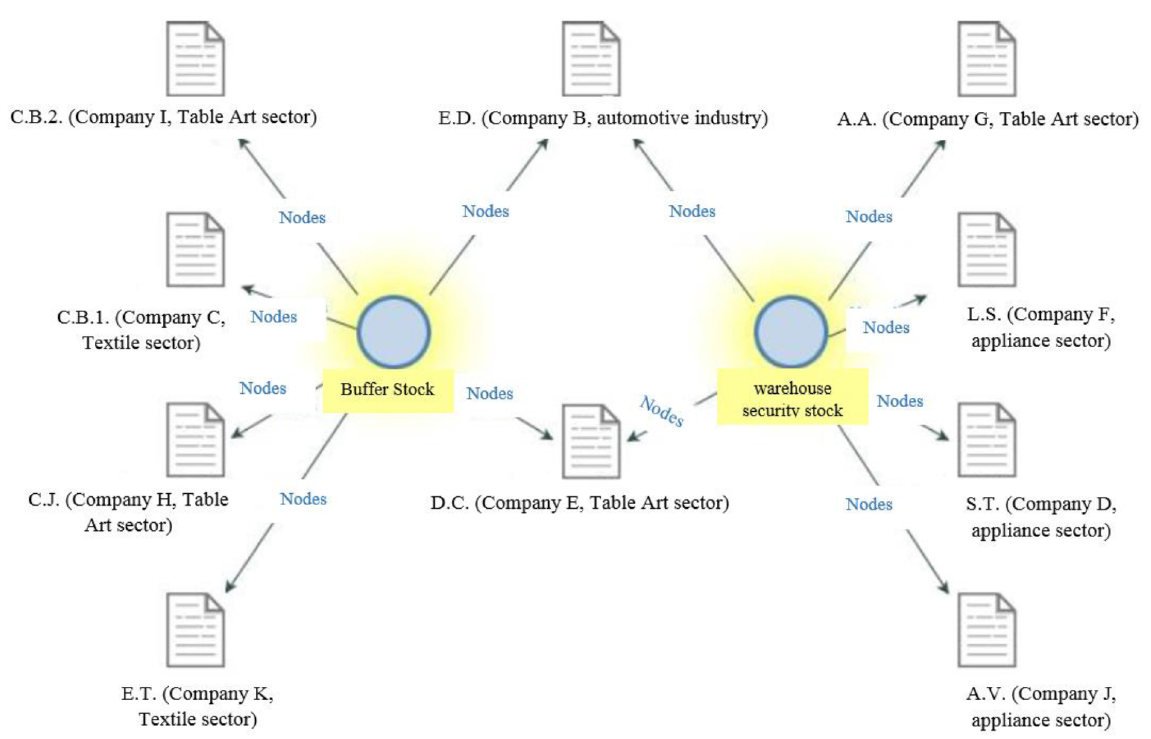
Figure 3. Encoding of the “buffer stock” and “warehouse stock” nodes under NVivo